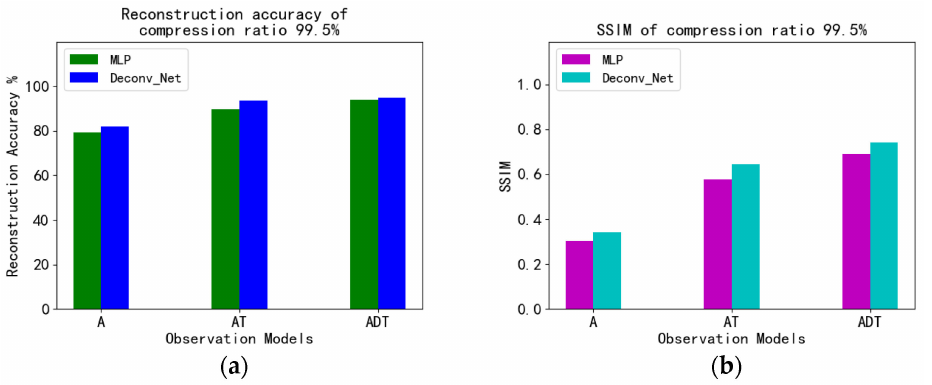
Figure 17. Reconstruction results of at a 99.5% compression ratio.